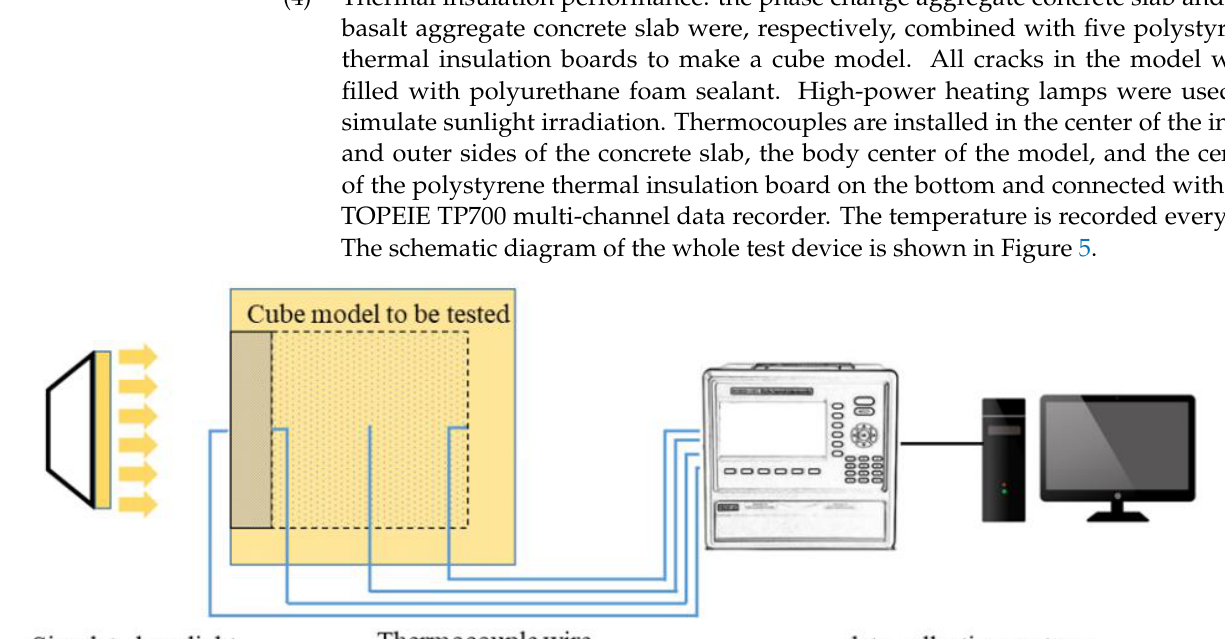
Figure 5. Test system for the thermal insulation performance of cube model.